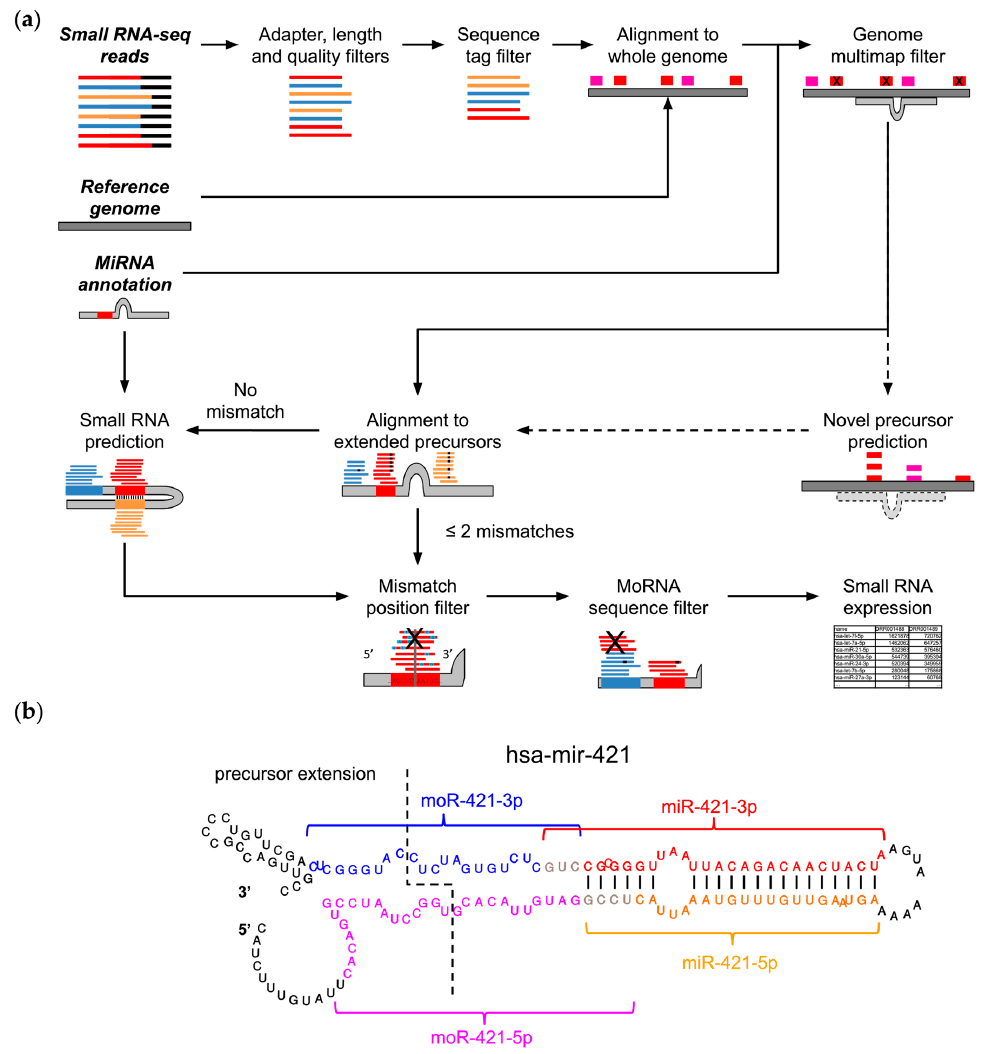
Figure 1. MiR&moRe2 features. ( a ) The miR&moRe2 pipeline workflow for sRNA data processing. Input data on the top left is highlighted by bold italic text. Dashed arrows indicate optional processing steps, bars represent adapter (black) and sRNA sequences: known miRNAs (red), unknown complementary miRNAs (orange) and moRNAs (blue). The extended miRNA precursor and its folding is represented in grey, along with vertical black bars indicating the complementary bases for novel miRNA prediction; ( b ) Secondary structure of the hsa-mir-421 miRNA precursor hairpin, with extended nucleotides at both ends (left side of the dashed line). Colored fonts and curly brackets indicate the positions of the annotated miR-421-3p (red font), and the three sRNAs predicted by miR&moRe2: the complementary miRNA miR-421-5p (orange font), moR-421-3p (blue font) and moR-421-5p (magenta fonts). Sequences of miRs and their adjacent moRs may overlap in few terminal bases (grey font). Vertical bars connecting the miRBase annotated miR-421-3p and the newly predicted miR-421-5p bases indicate the complementary miRNA sequence predicted by miR&moRe2, according to the precursor